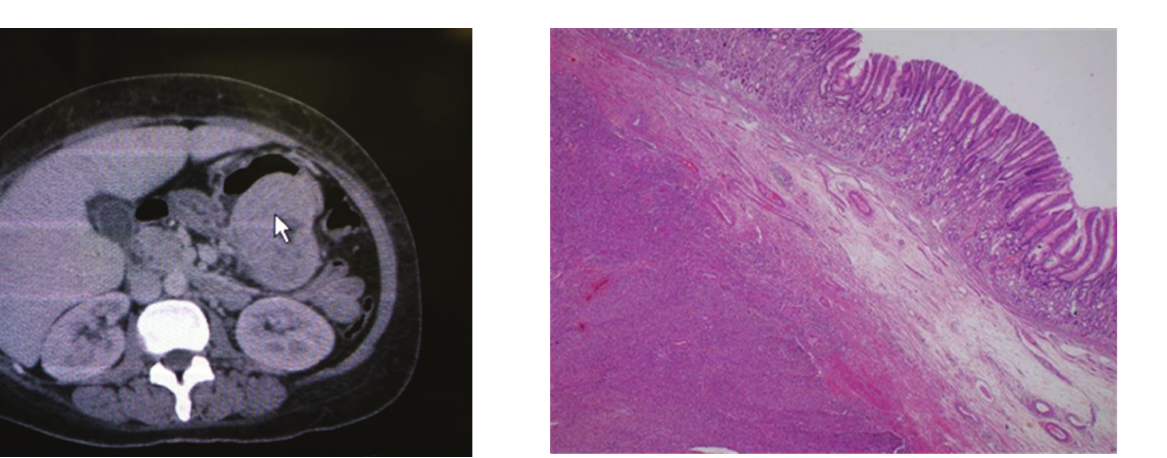
Figure 1: CT scan showing the lesion in the posterior wall of stomach (arrow).